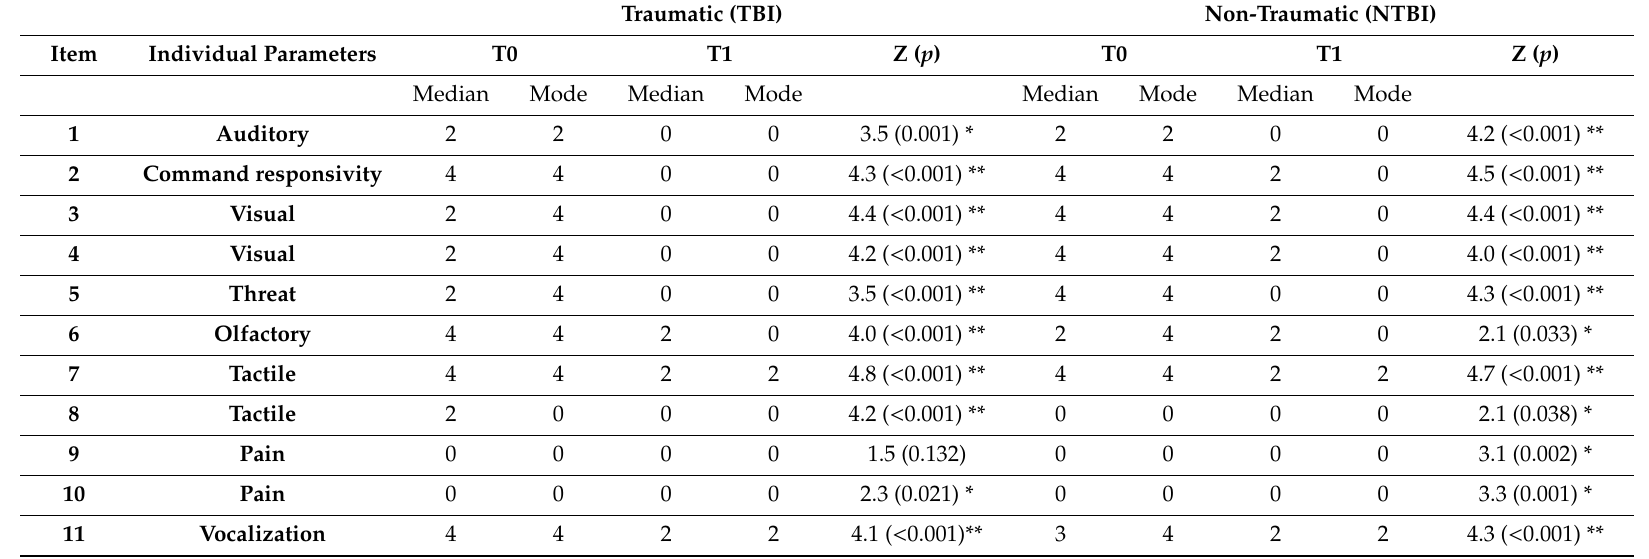
Table 3. Scores for 11 single CNCS items at T0 and T1, and results of the comparison of each item at T0 vs. T1. Results refer to the samples with TBI ( n = 44) and NTBI ( n =